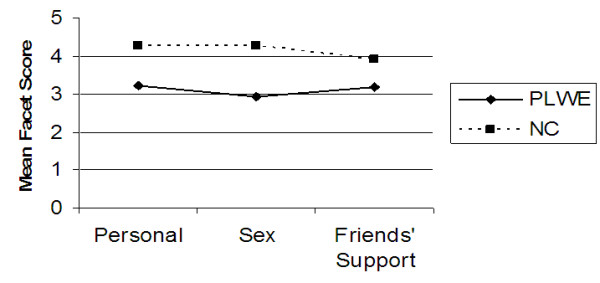
Facets determining the social relationships QOL domain. X axis represents the three facets that comprise the social relationships QOL domain. Y axis represents the mean facet score (0 to 5).